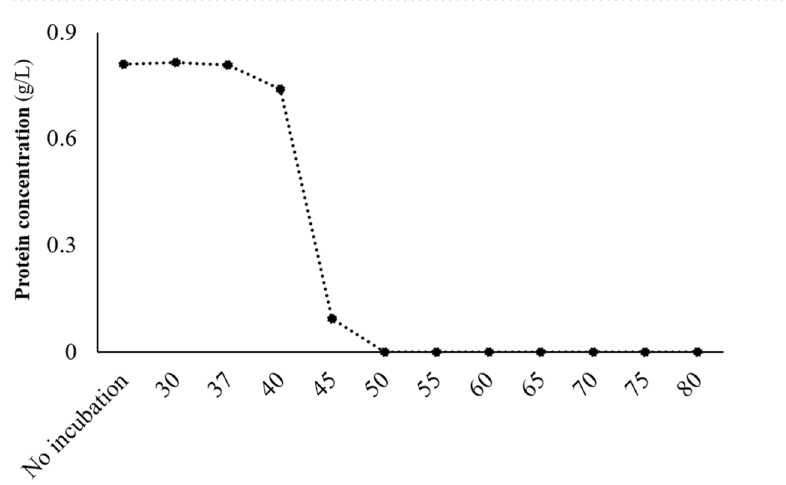
Figure 4. Thermostability analysis of alginate lyase (ID 22) at different temperatures (30 to 80